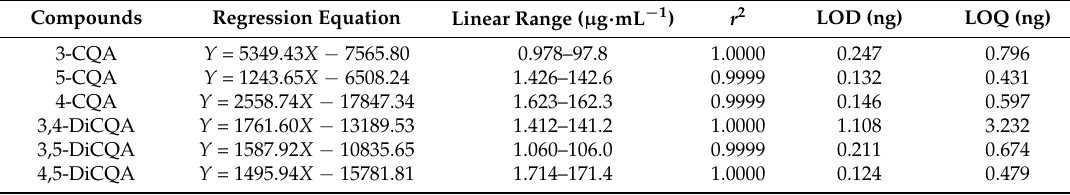
Table 1. Calibration curves, linearity, LOD and LOQ for 6 investigated CQAs.